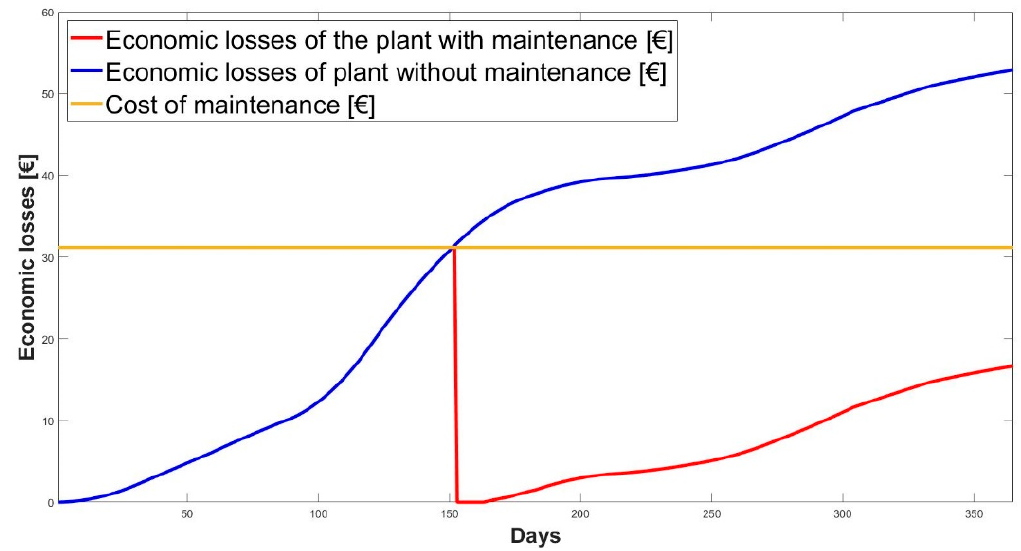
Figure 16. Optimal cleaning interval for the CIESOL plant (9 kWp) from an economic standpoint.